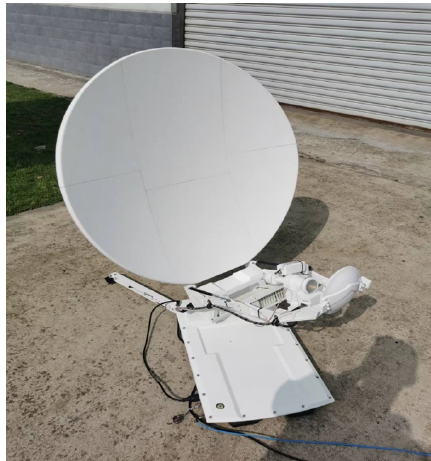
Figure 2. The satellite ground